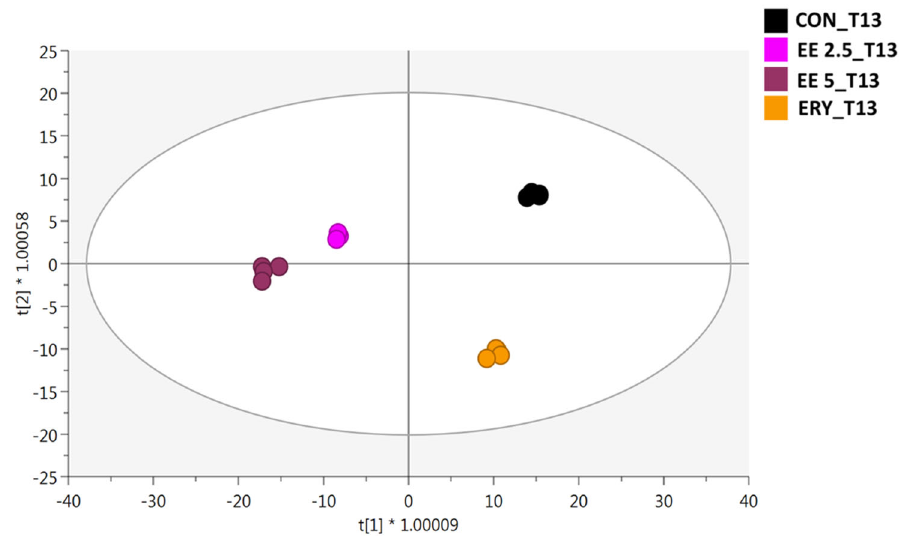
Figure 4. Orthogonal projections to latent structures discriminant analysis (OPLS-DA) considering Figure 4 . Orthogonal projections to latent structures discriminant analysis (OPLS ‐ DA) considering the different beef burgers (CON, EE 2 ‐ 5, EE 5, and ERY) at the final time ‐ point of the storage pe ‐ the different beef burgers (CON, EE 2-5, EE 5, and ERY) at the final time-point of the storage period riod (13 days). (13